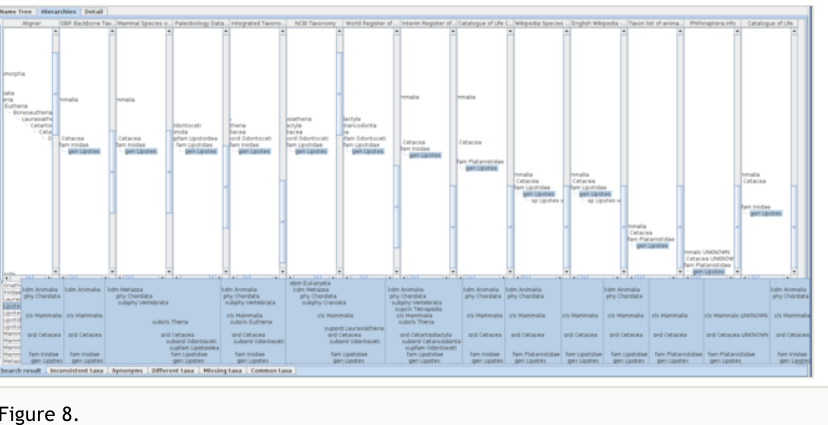
Hierarchies containing Lipotes name usage are compared on a screen of 1920 pixels wide. Width of each column is insu ffi cient to display a hierarchy of full depth but the pop-up gives a sketch of hierarchies where unranked name usages are not